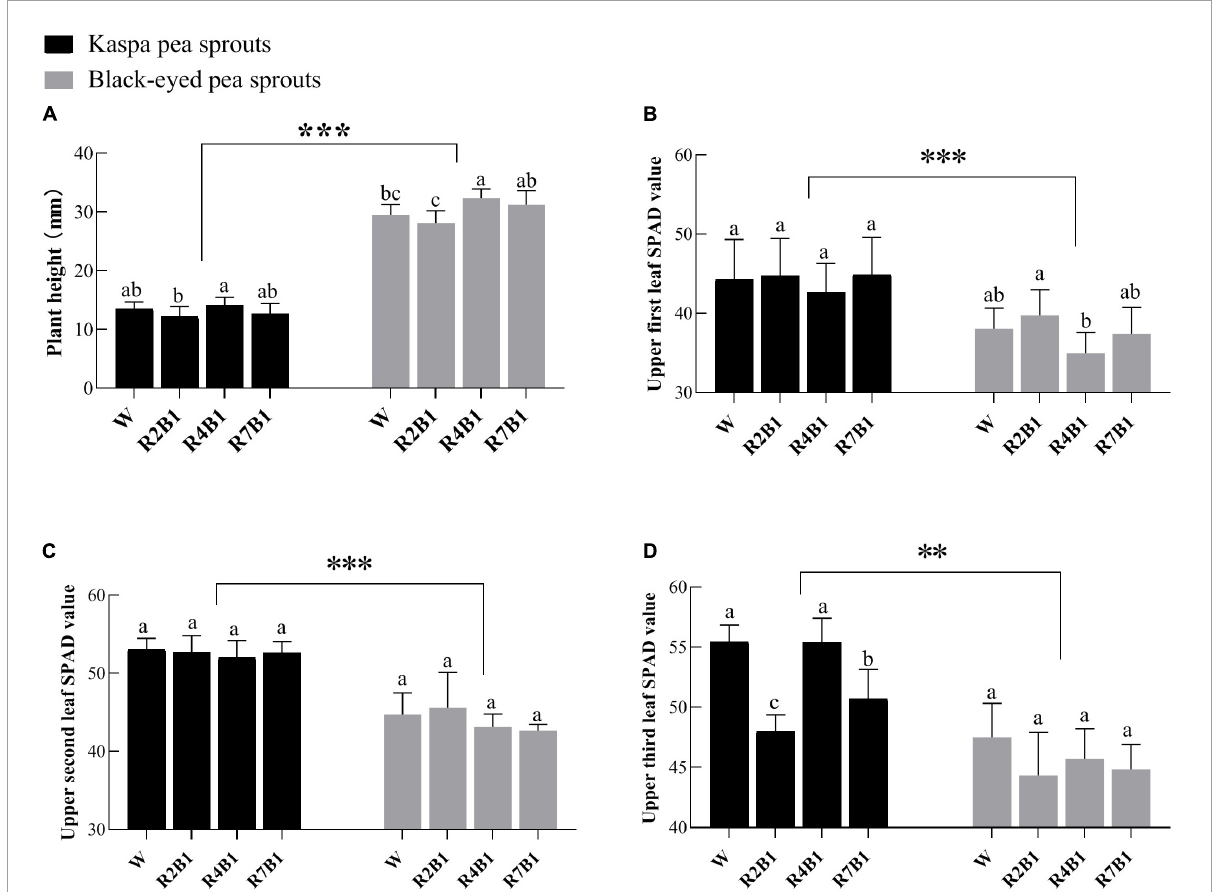
FIGURE2 Effects of four LEDs’ light quality combinations on the plant height and SPAD value of the two cultivars of pea sprouts. (A) Plant height; (B) upper first leaf SPAD value; (C) upper second leaf SPAD value; (D) upper third leaf SPAD value. Different letters indicate significant differences at P ≤ 0.05 of the same variety among treatments. ∗∗ and ∗∗∗ denote significant differences at P ≤ 0.01 and P ≤ 0.001 of different varieties. Error bars represent six